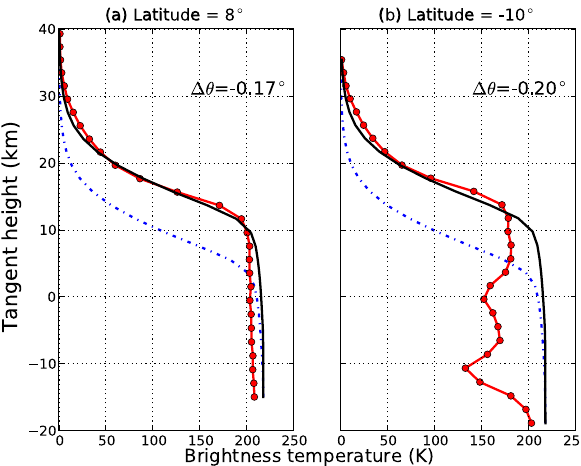
Fig. 2. Measured brightness temperature (red circles) with respect to corrected tangent heights at 624.547GHz: (a) clear sky case for a latitude of 8 ◦ N, and (b) for a latitude of 10 ◦ S with scattering ice particles. The black line is a calculation using the line-of-sight tangent altitude corrected before the retrieval calculation and the blue dotted line is the calculation on the original line-of-sight tan- gent altitude. The correction is − 0.17 ◦ (about 6km) for case (a) and − 0.19 ◦ (about 7km) for case (b) . Data are two single scans measured on 14 April